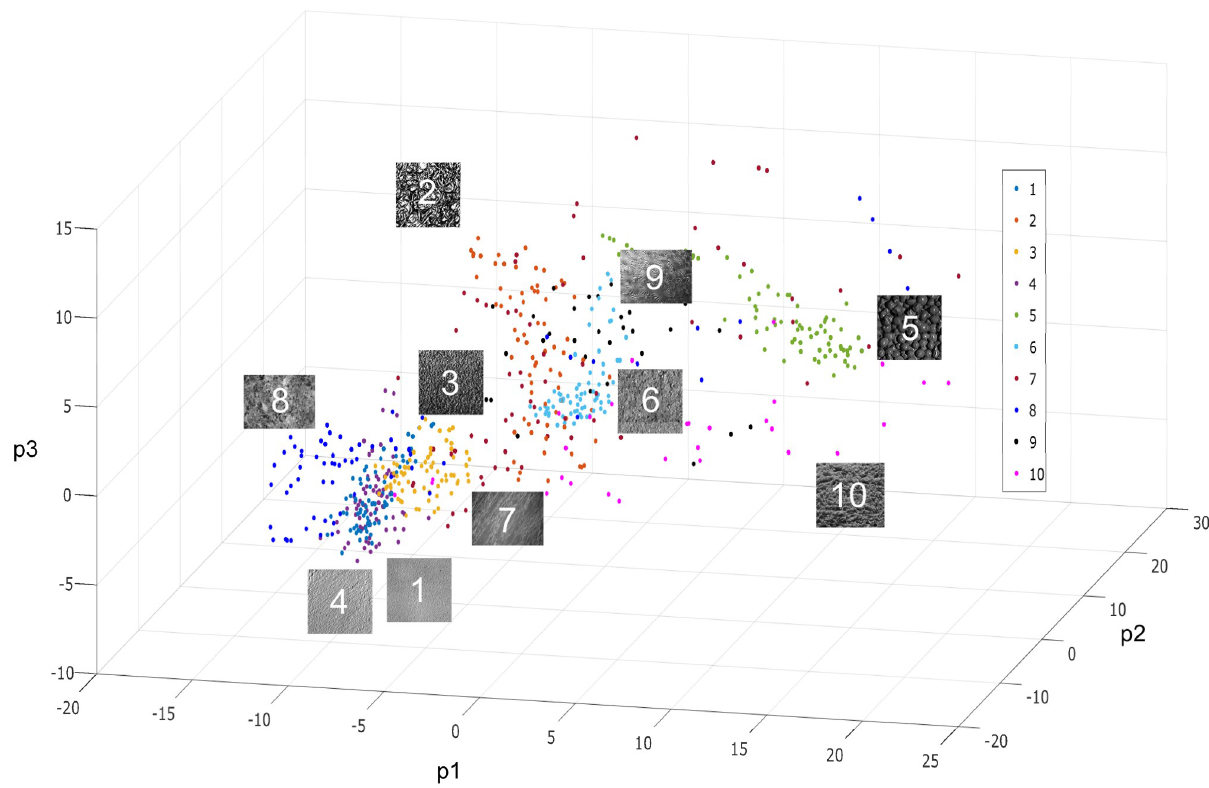
Fig 3. Example texture image data. This example has an assortment of 10 texture classes taken from the CuRET, UIUC and KTH-TIPS databases, each represented by a color-coded cluster, with each cluster consisting of a variable number of sample images taken under different orientations, lighting conditions and scales. Multi-resolution Haralick and local binary pattern texture features were computed, and then principal component analysis (PCA) was performed for visualization purposes and the data plotted with respect to the first three principal component axes. PCA was not performed as part of linkage